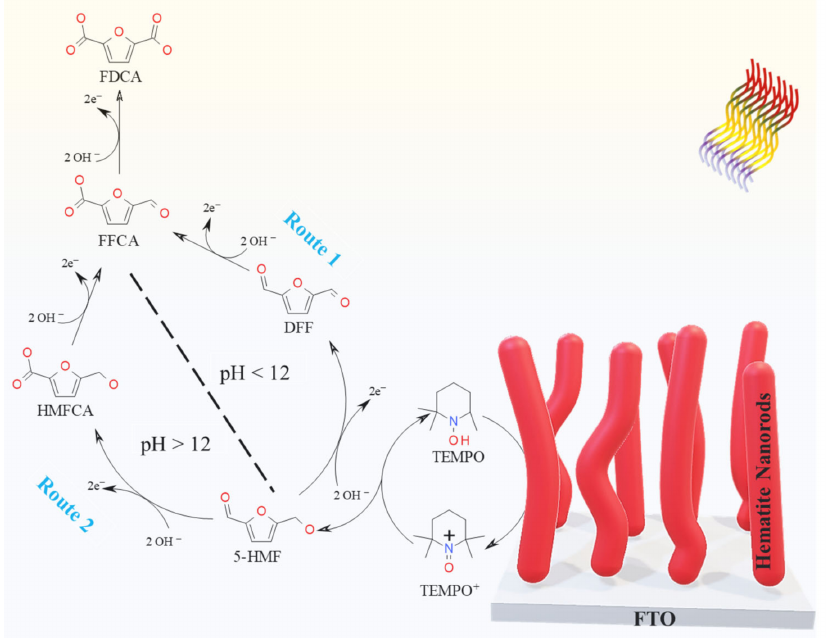
Figure 4. Schematic representation of the possible pathways of 5-HMF oxidation to FDCA at pH higher than 12.0 and pH less than